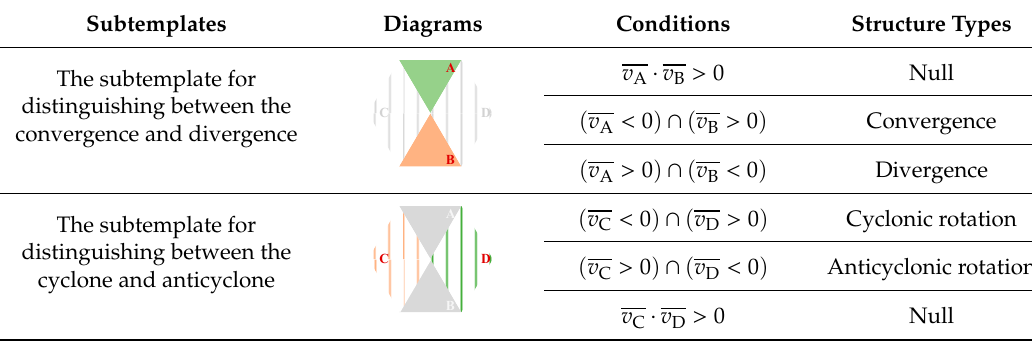
Table 2. Classification rules of airflow field structure types.